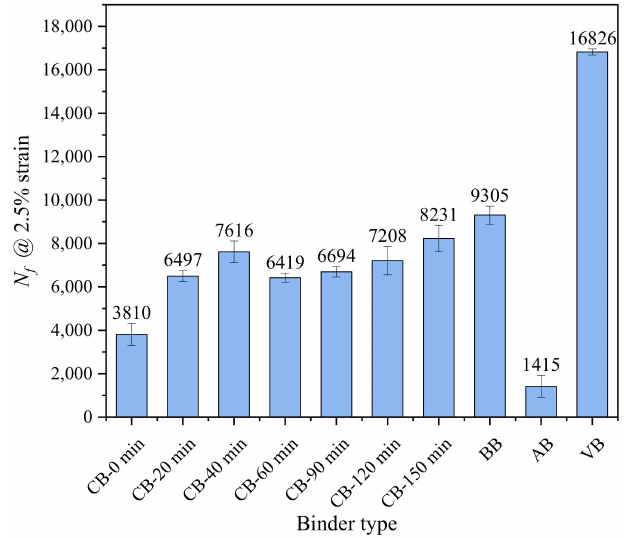
Figure 13. Fatigue life of binders at 2.5% strain